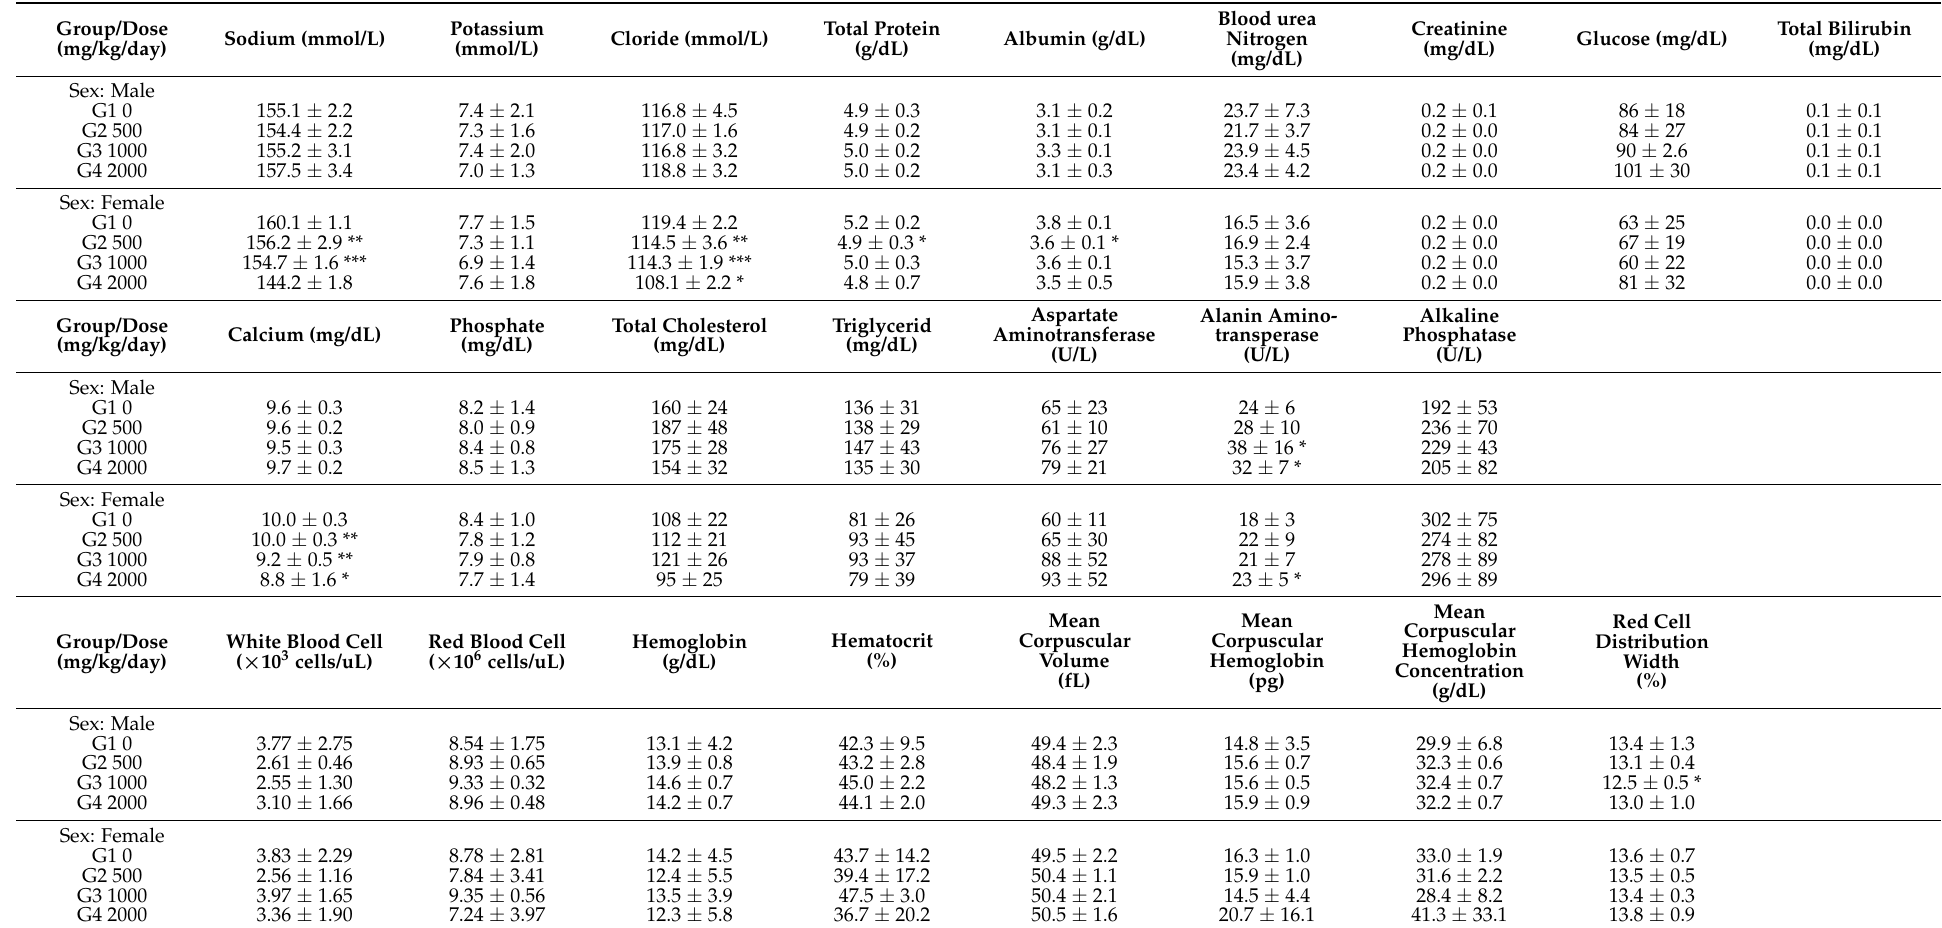
Table 1. Clinical pathology analysis in 28-day repeated oral dose toxicity study. Male and female serum biochemistry results and male and female hematology data. Results are expressed as mean ± SD. * p < 0.05, ** p < 0.01, *** p < 0.001 vs.